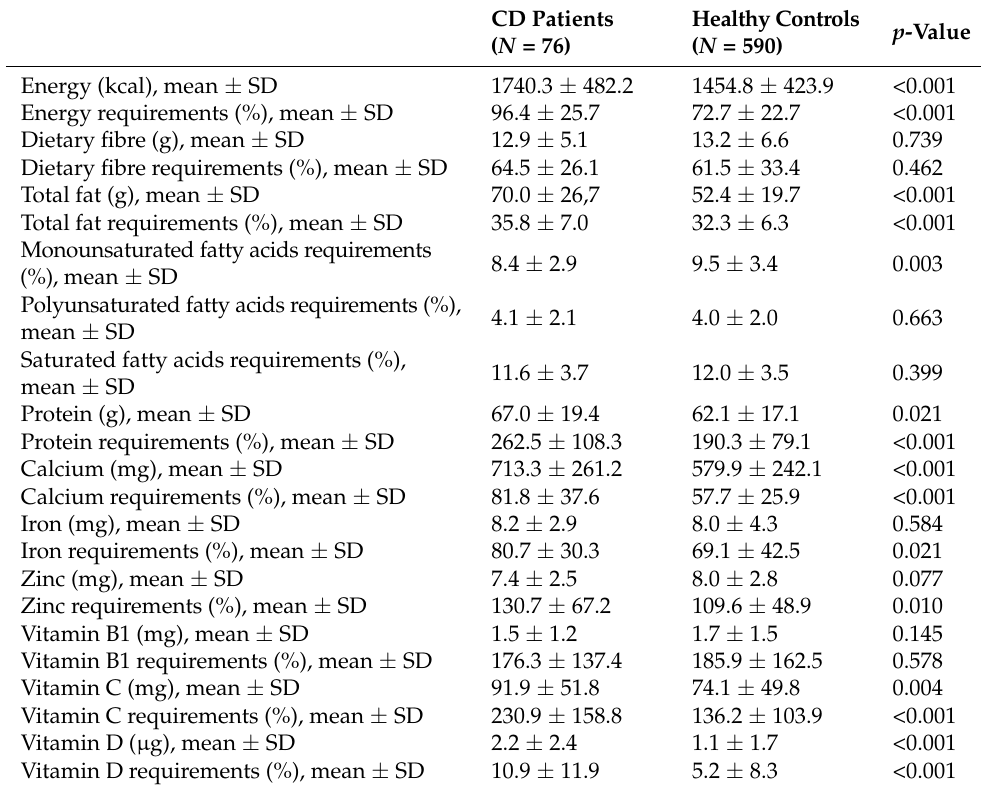
Table 2. Comparison of nutritional intake between CD patients on GFD and healthy